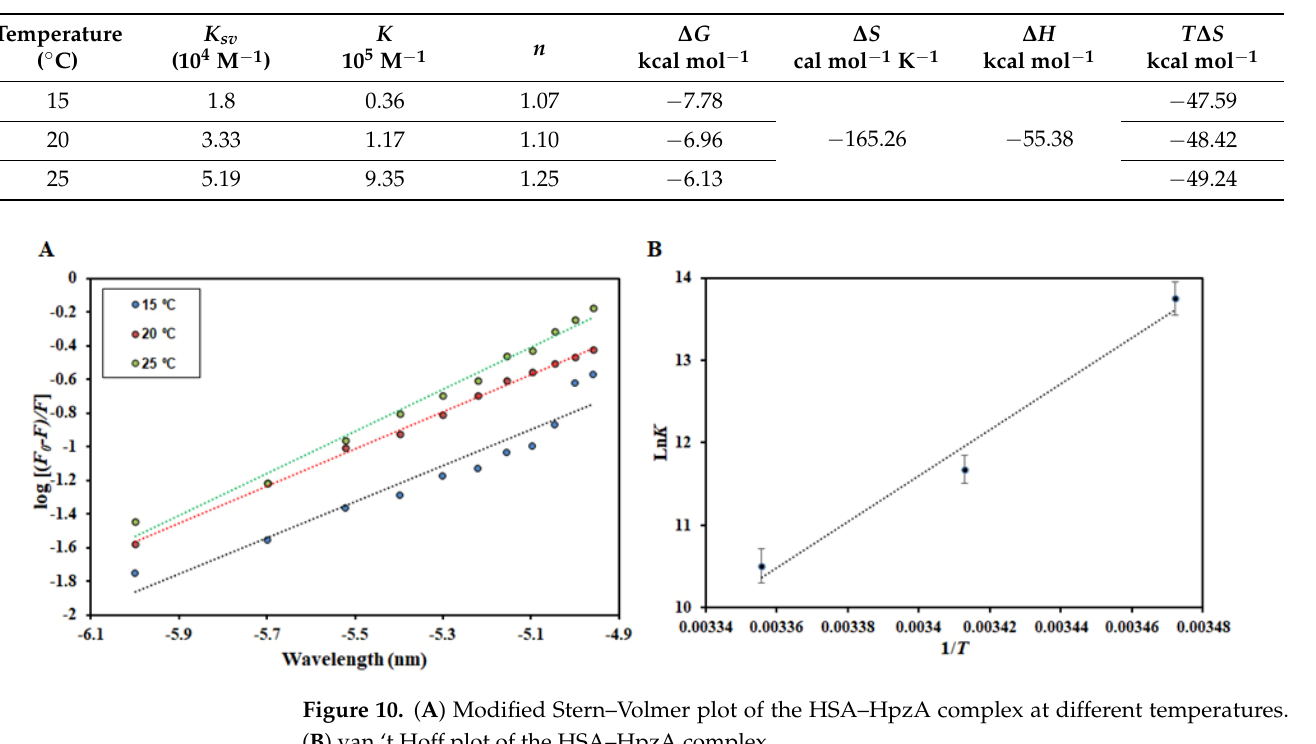
Table 1. Binding and thermodynamic parameters obtained for the HSA–HpzA complex from fluores- cence quenching studies.